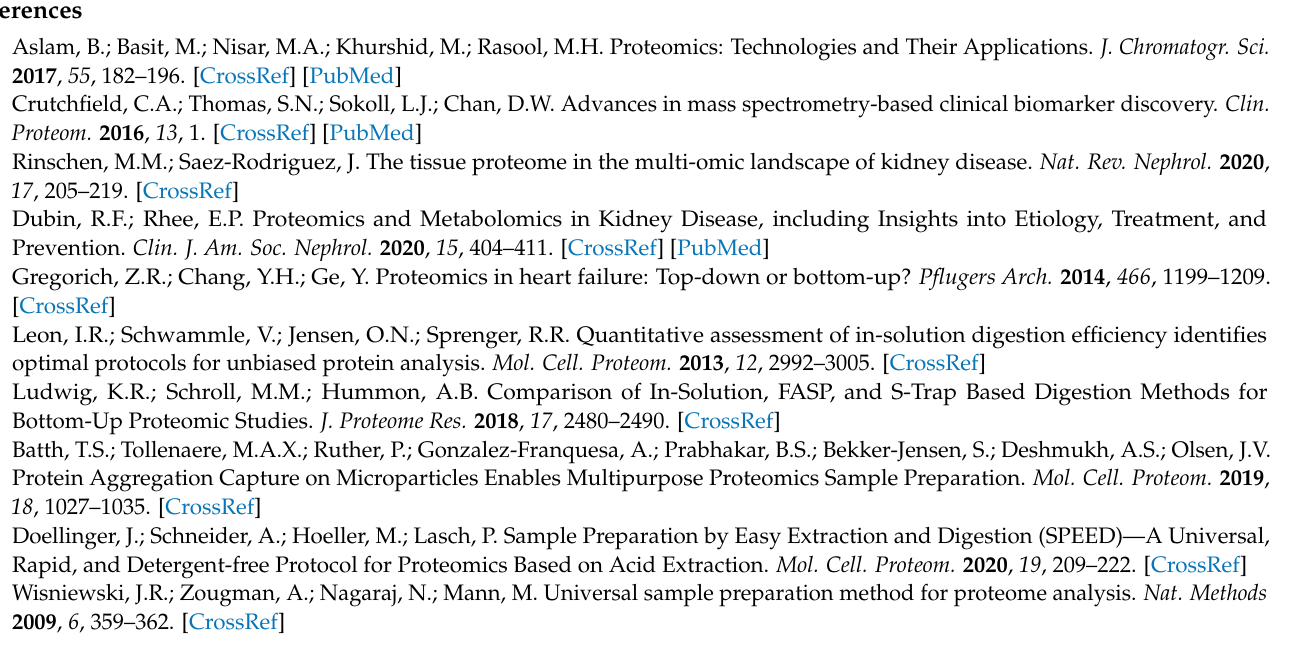
Table S5: Peptides used for retention time alignment in kidney tissue; Table S6: ANOVA p -values for physical characteristics of peptides; Table S7: ANOVA pairwise comparisons for molecular weight; Table S8: Mean molecular weight of peptides; Table S9: ANOVA pairwise comparisons for peptide length; Table S10: Mean peptide length; Table S11: Mean GRAVY